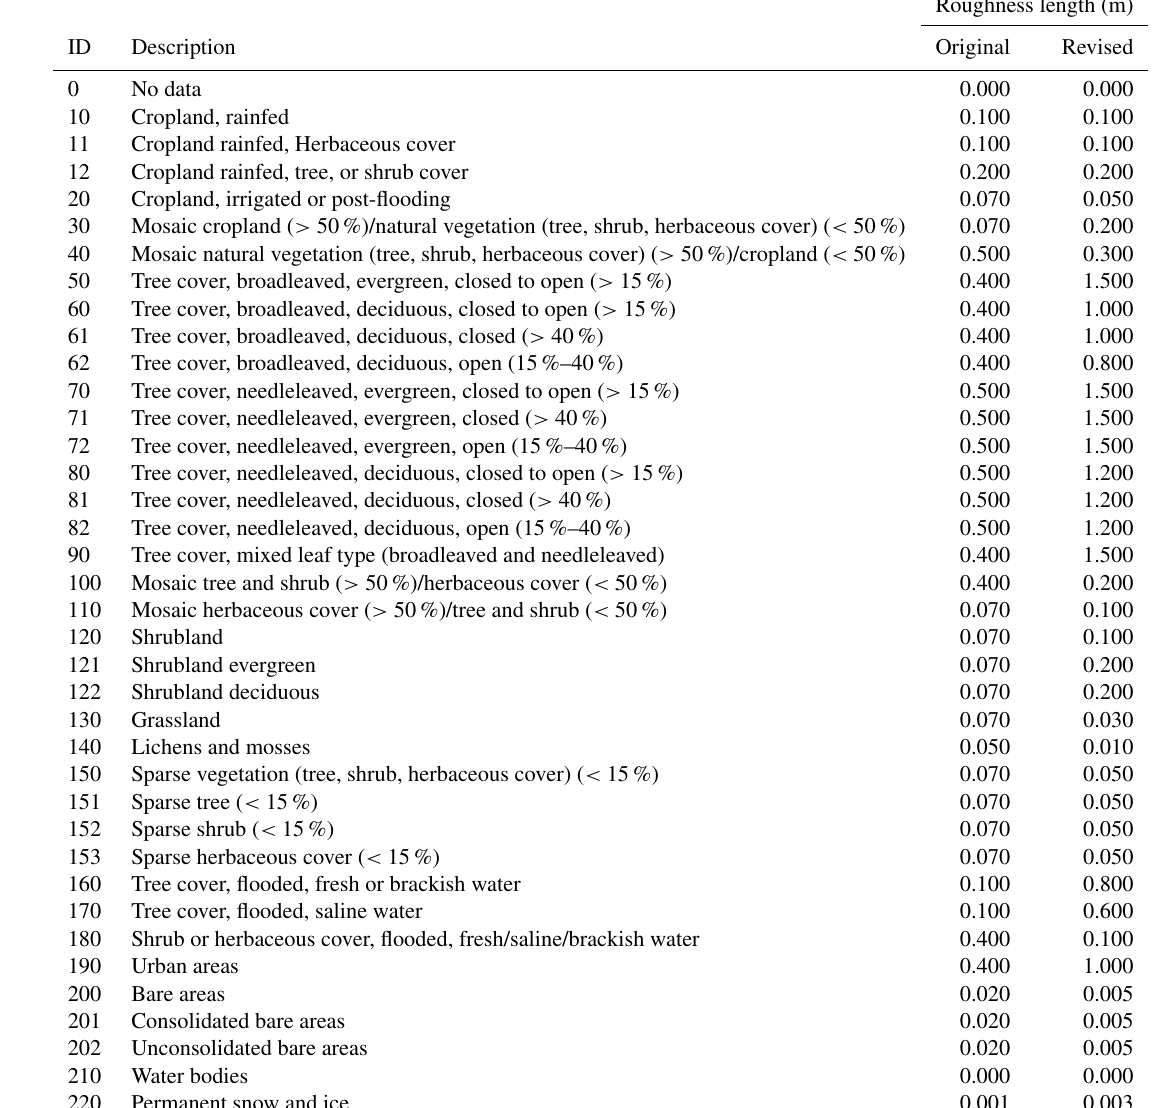
Table A3. Land cover table used for the GlobCover/ESA-CCI database (Thøgersen,